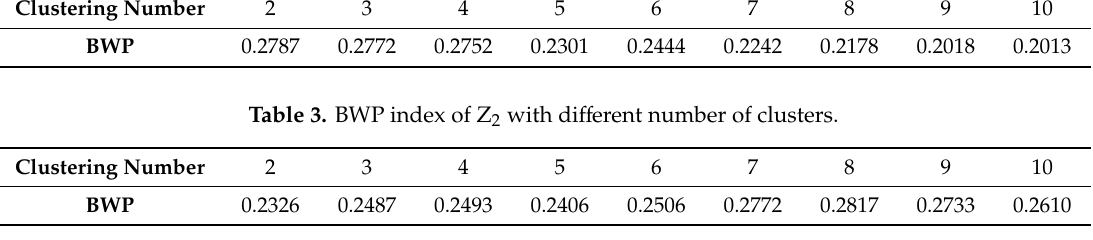
Table 4. BWP index of Z 3 with di ff erent number of Table 3. BWP index of Z 2 with different number of clusters.